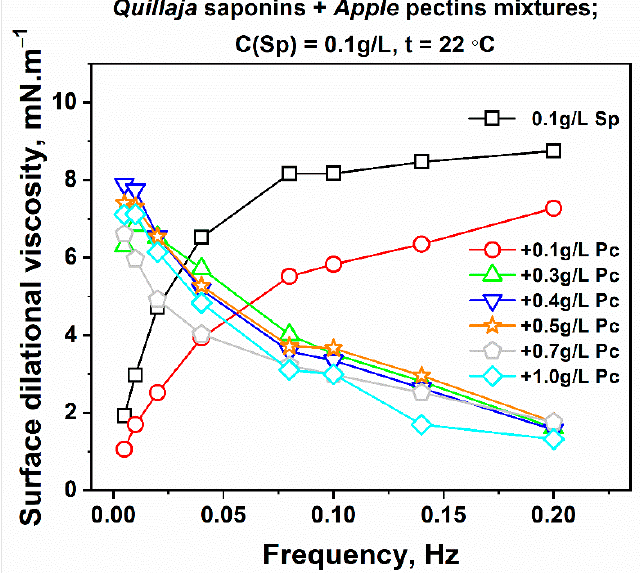
Figure 5. Surface dilational viscosity of adsorption layers of Quillaja saponin-only, and Quillaja saponin and Apple pectin mixtures at constant saponin concentration (C(Sp) = 0.1 g/L) and various Apple pectin concentrations against the frequency of the bubble’s deformations.